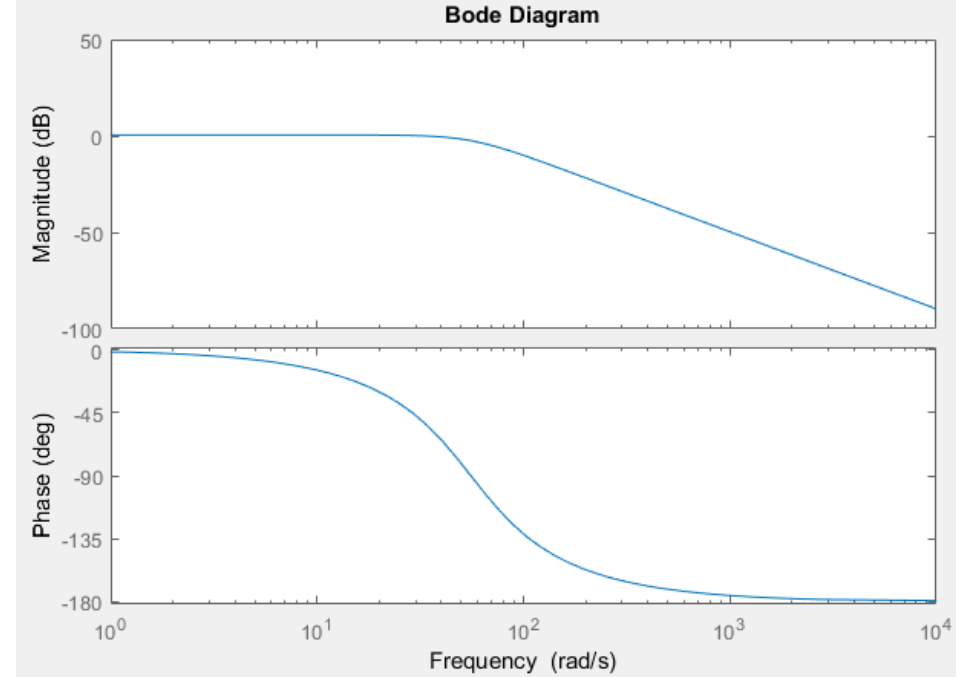
Figure 9. This figure shows the response dynamics of the sensor in terms of frequency. We can see that the sensor can measure correctly up to a lower frequency of 40.6 rad/s. Up to a frequency of 55.6 rad/s the system enters into resonance, as this value is the natural frequency of the parallel mechanism.